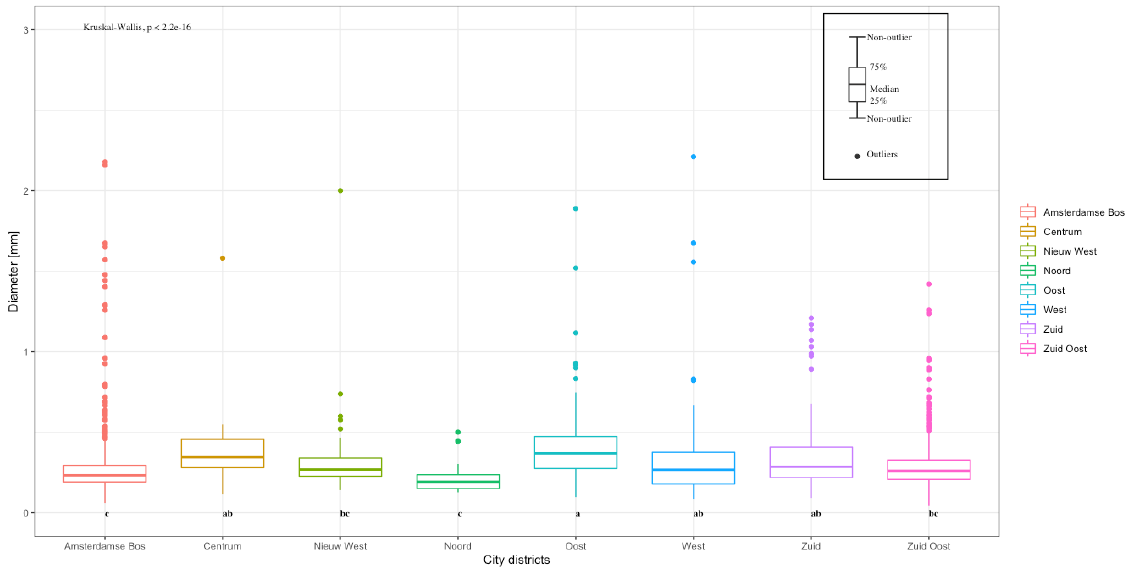
Figure 3. Size distribution (diameter in mm) of microplastic particles (n = 1748) in soils from parks and recreational areas (n = 74), which were analysed by city district in Amsterdam. Significant differences between city districts ( p < 0.05) are indicated by lowercase letters (a > b > c).